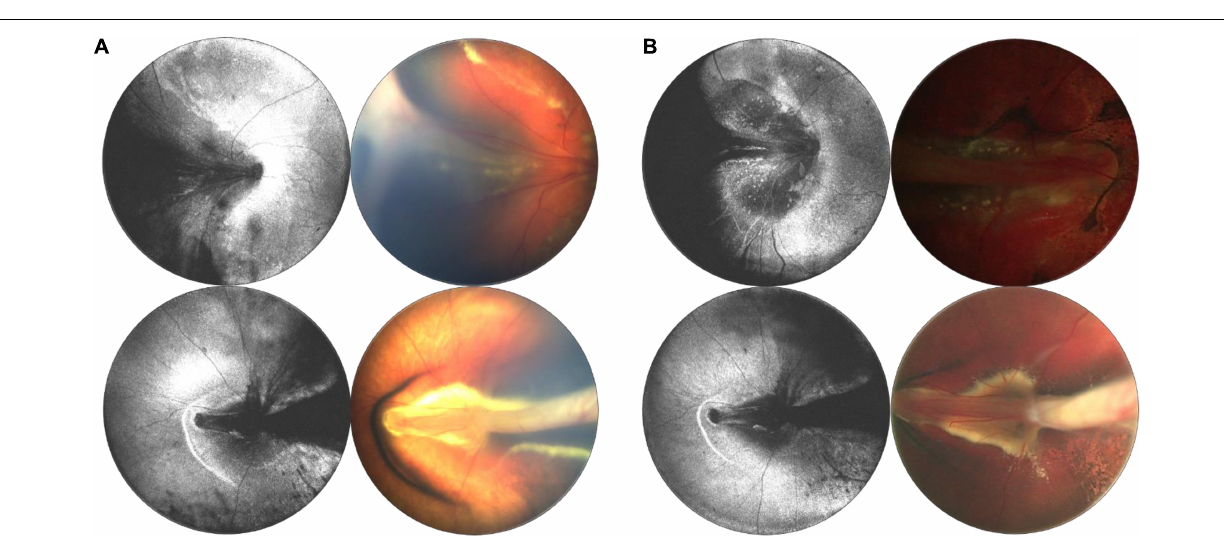
FIGURE 11 | Longitudinal monitoring of a patient with familial exudative vitreoretinopathy (FEVR). (A) Pre-surgical repair of bilateral tractional retinal detachments secondary to FEVR in a 4-month-old patient taken with 55 ◦ FOV device. (B) Post-surgical repair images, with OCT en face taken 1 week after surgery, and fundus photographs taken 3 months after surgery. For panels (A,B) , left column are OCT en face projections, whilst right column are color fundus